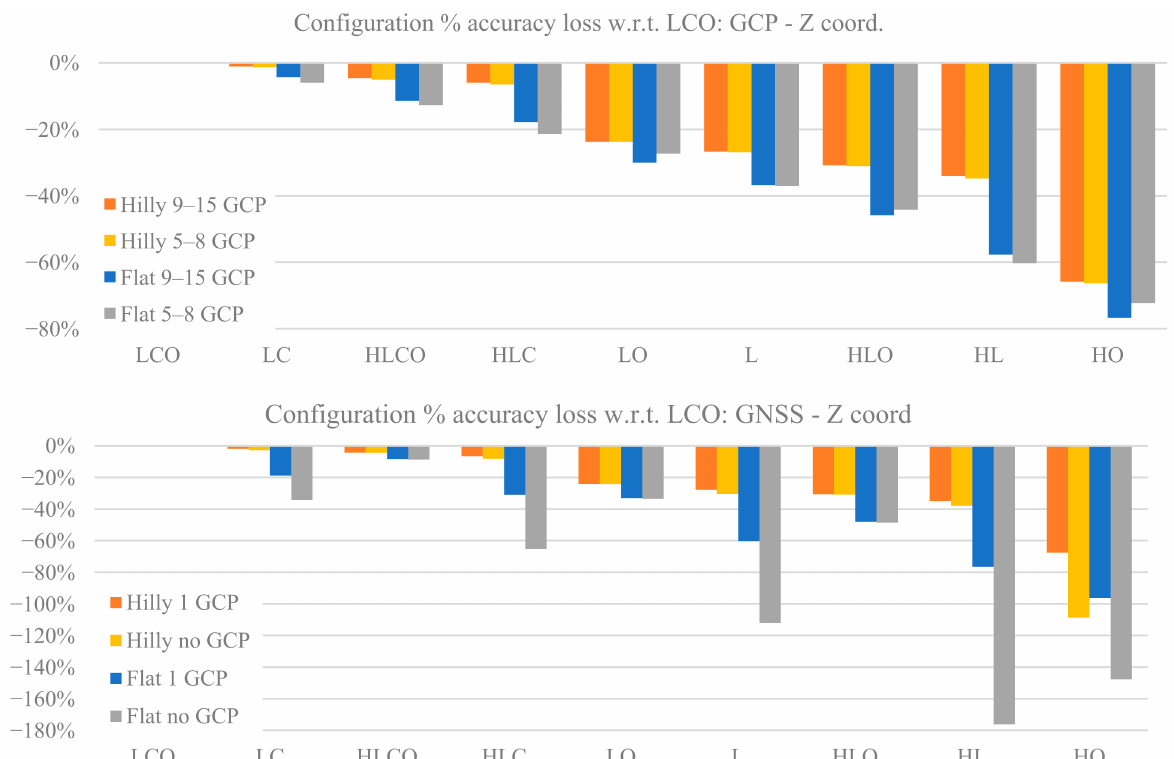
Figure 8. X, Y and Z tie points’ coordinates in GCP and GNSS cases: percentage RMSE loss of each of the nine block configurations w.r.t. the reference block configuration (LCO), as a function of terrain type and control tightness; ( top ): X, Y coordinates; ( bottom ): Z